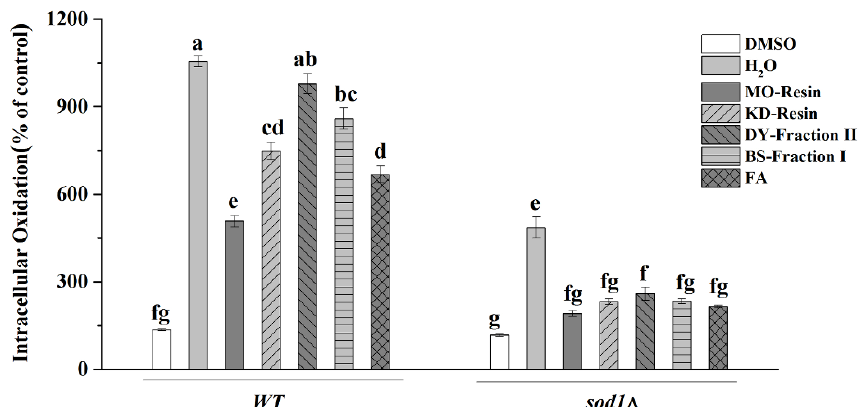
Figure 6. The results of intracellular oxidation were expressed as the ratio between treated or not treated with herbal teas or green teas, stressed and non-stressed cells. The data represent the means ± SD of at least three independent experiments. The capital letters mean statistically different results at p < 0.05.